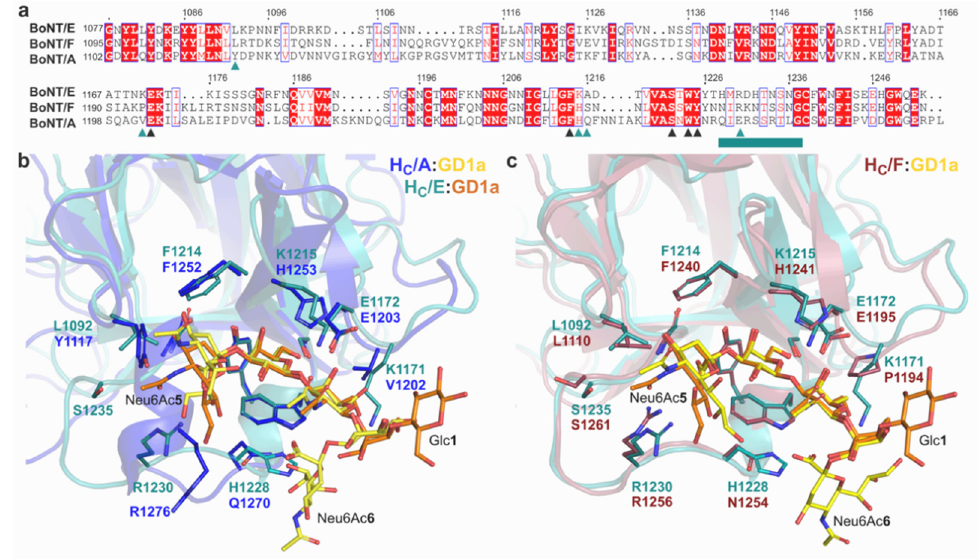
Figure 5. A unique binding site. ( a ) Sequence alignment of the binding domains from BoNT/E,/F and/A, (prepared with ESPript [36]). Identical residues are shown with a red background, and similar residues are boxed. Loop 1227–1238 of BoNT/E is underline (teal). Conserved and unique BoNT/E residues involved in ganglioside binding are marked with black or teal triangles, respectively. ( b ) Superposition of the H C /E(teal):GD1a(orange) complex with H C /A(blue):GD1a (yellow) from PDB 5TPC [31] and ( c ) with H C /F(red):GD1a(yellow) from PDB 3RSJ [20], respectively.